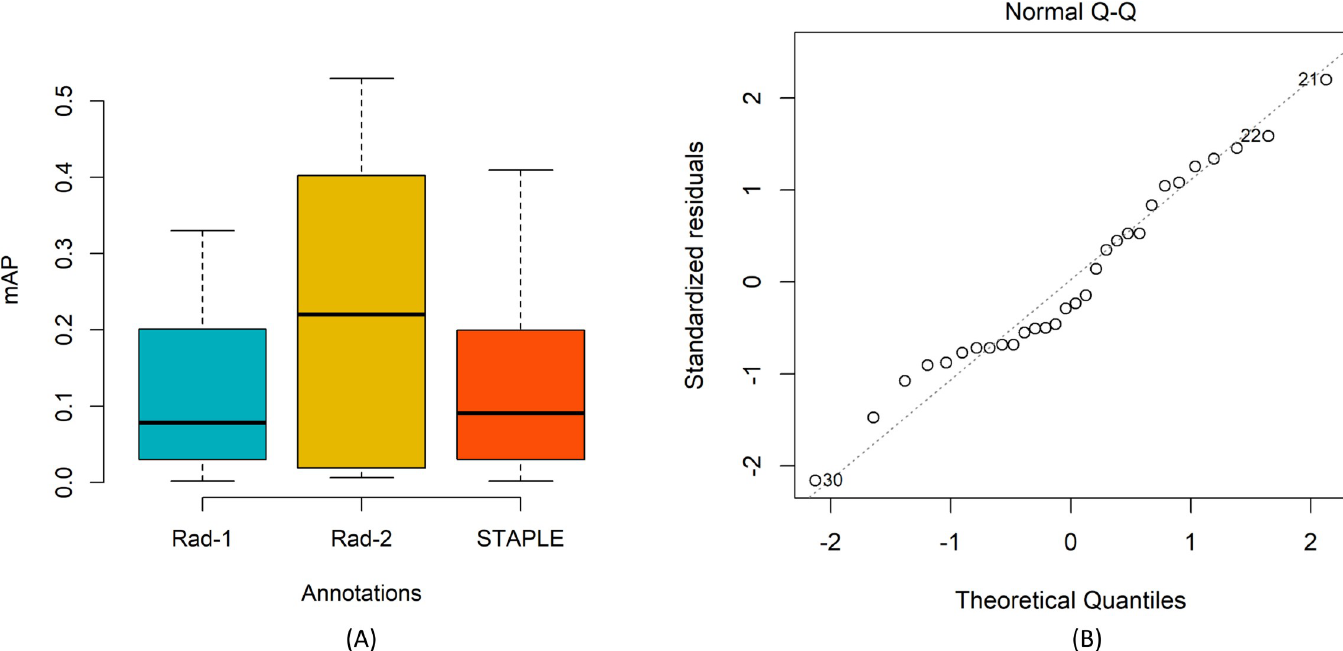
Fig 16. Statistical analyses. (A) Mean plot for the mAP scores obtained by the top-N ensembles using Rad-1, Rad-2, and STAPLE-generated consensus ROI annotations; Error bars represent standard errors. The differences are not statistically significant; (B) Residual plot showing the data follow the normal distribution.